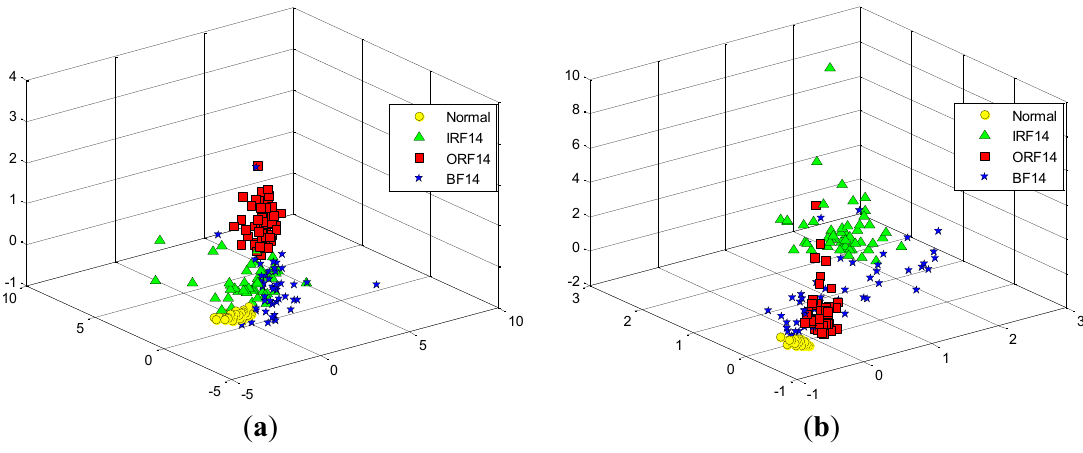
Figure 11. The randomly selected three features from the total 29 features in the D_MIX dataset: ( a ) the first selection. ( b ) the second selection.